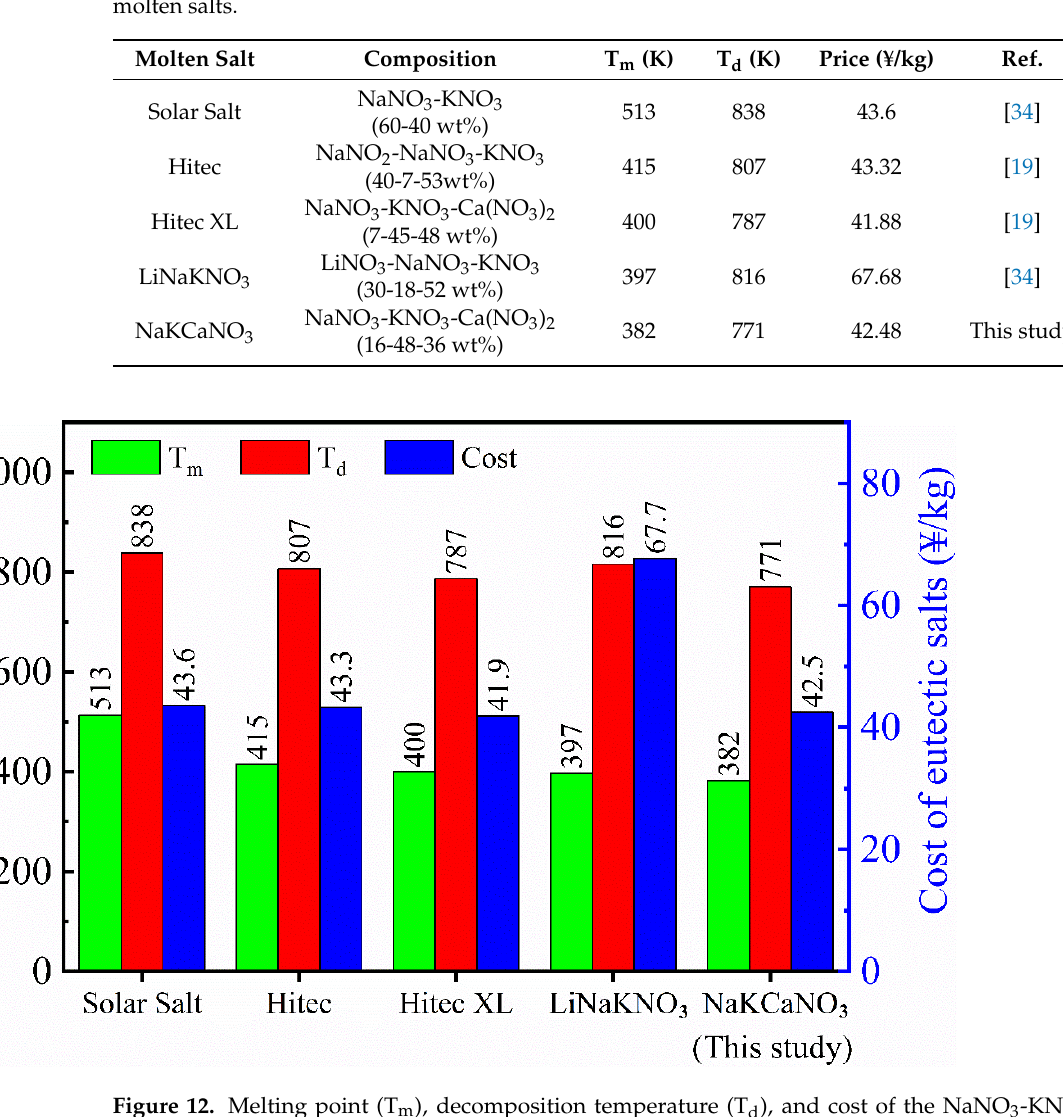
Table 2. Key phase change thermal-physical properties and cost of currently potential nitrate/nitrite molten salts.